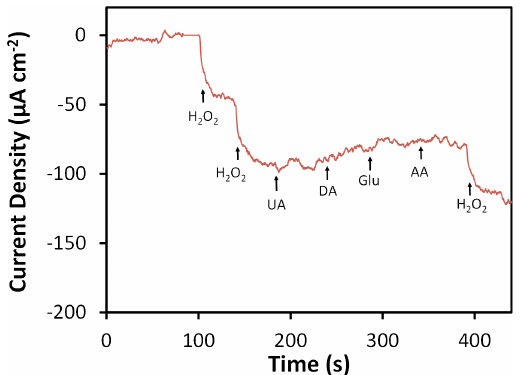
Figure 7. Amperometric response of N-SPCE towards H 2 O 2 and common interfering species in 0.05 M phosphate buffer (pH 7.4) at − 0.4 V vs. Ag/AgCl. Arrows and labels indicate injection times and species. Spiked concentrations for H 2 O 2 , uric acid (UA), dopamine (DA), glucose (Glu), and ascorbic acid (AA) were 0.1 mM for each injection. Table 1. Spike recoveries for H 2 O 2 in bovine calf serum measured using N-SPCE at − 0.4 V in 0.05 M phosphate buffer (pH 7.4) and comparison of amperometric detection to an ABTS-HRP-based assay for H 2 O 2 [41]. Results are presented as average (±1 standard deviation) ( n = 3). Spiked (mM) Measured (mM) % Recovery ABTS-HRP Assay (mM) 0.015 0.0137 (±0.00019) 91 (±1.3) 0.016 (±0.0011) 0.025 0.024 (±0.0010) 97 (±4.0) 0.024 (±0.0012) 0.080 0.074 (±0.0021) 93 (±2.7) 0.080 (±0.0012) 0.40 0.39 (±0.026) 98 (±6.5) 0.39 (±0.012) 2.50 2.49 (±0.062) 100 (±2.5) 2.41 (±0.040)